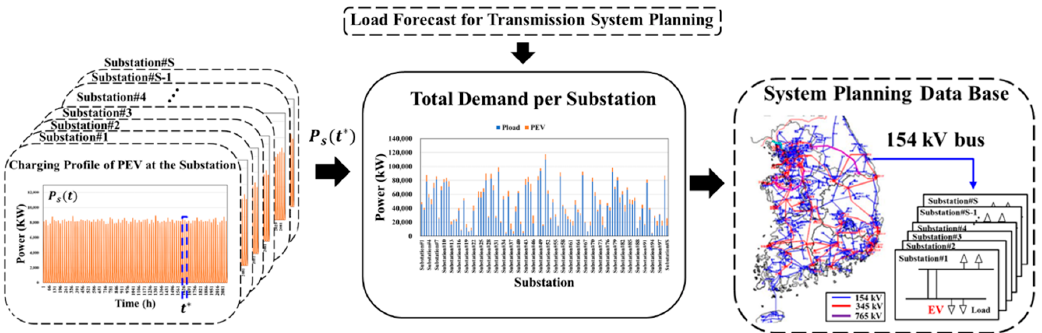
Figure 6. Overview of PEV charging demand modeling for transmission system planning.